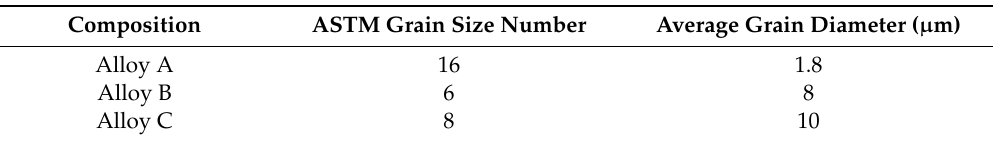
Table 3. ASTM (American Society for Testing and Materials) grain size number and average grain size of the vacuum hot pressed ferritic oxide dispersion strengthened alloys.